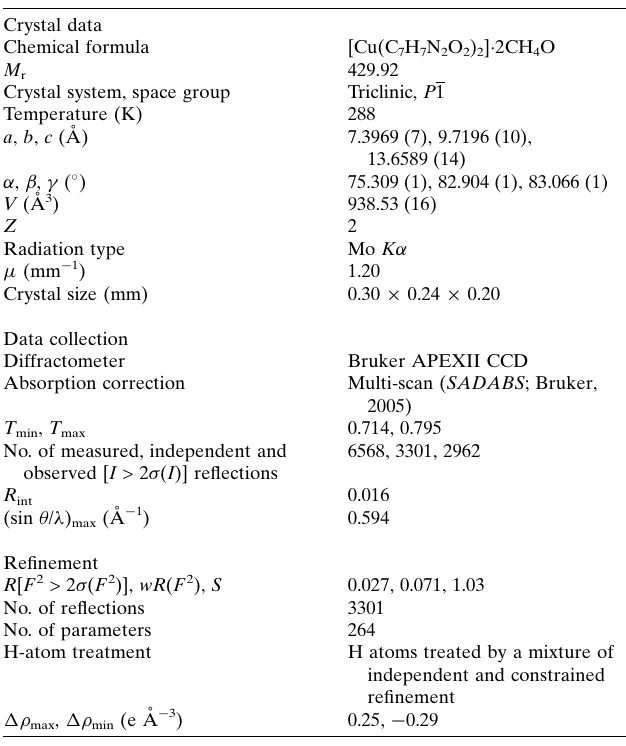
Table 2 Experimental details.